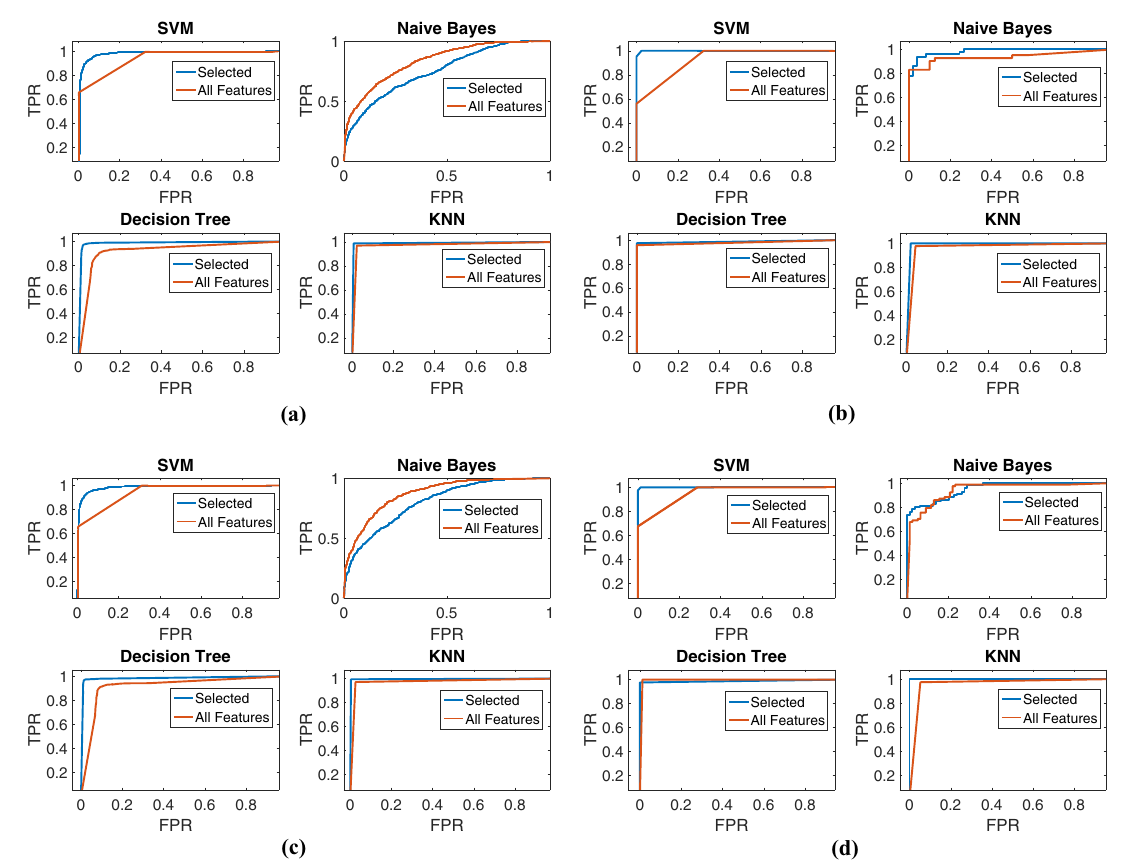
Figure 6 ROC curves of comparison results with different models using the selected features and all features in RLC